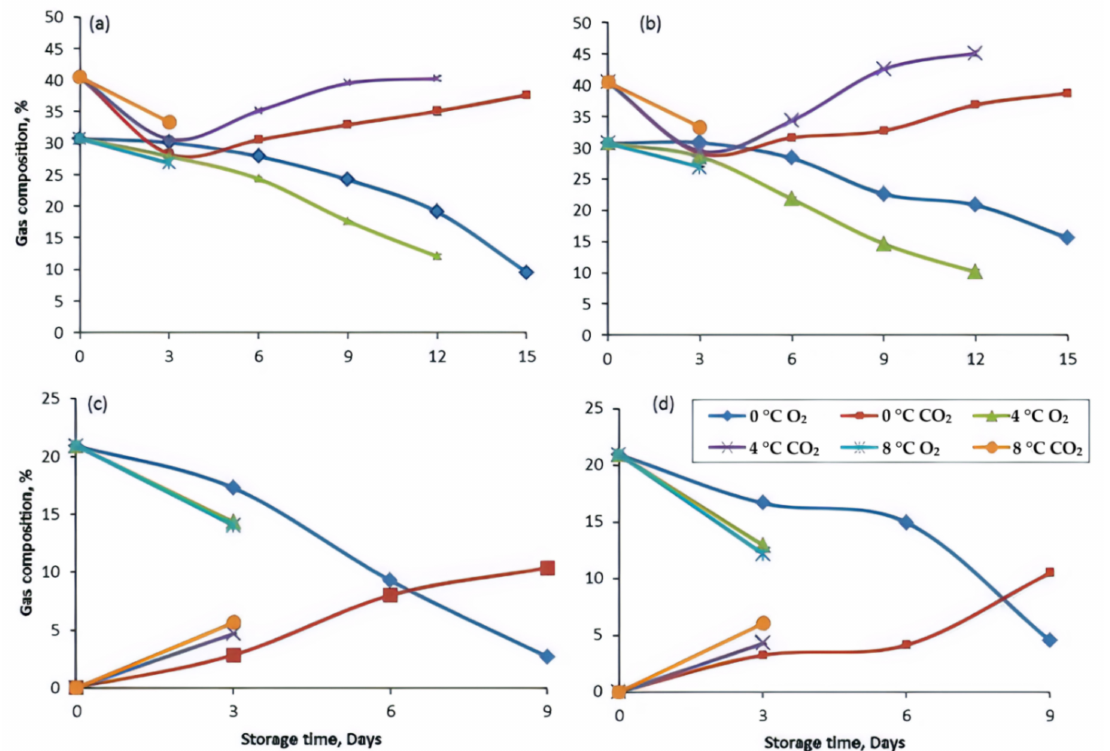
Figure 2. Effects of absorbent pads, packaging, temperature (0 ◦ C, 4 ◦ C, and 8 ◦ C), and time on oxygen and carbon dioxide gas composition during storage: ( a ) MAP with no PAD, ( b ) MAP plus PAD, ( c ) PMAP with no PAD, and ( d ) PMAP plus PAD. MAP = active-MAP and PMAP =